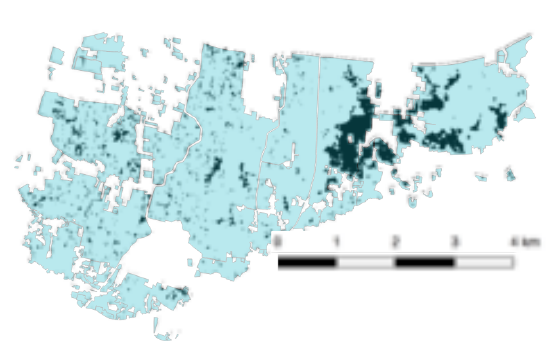
ESA 2018/03/01 c